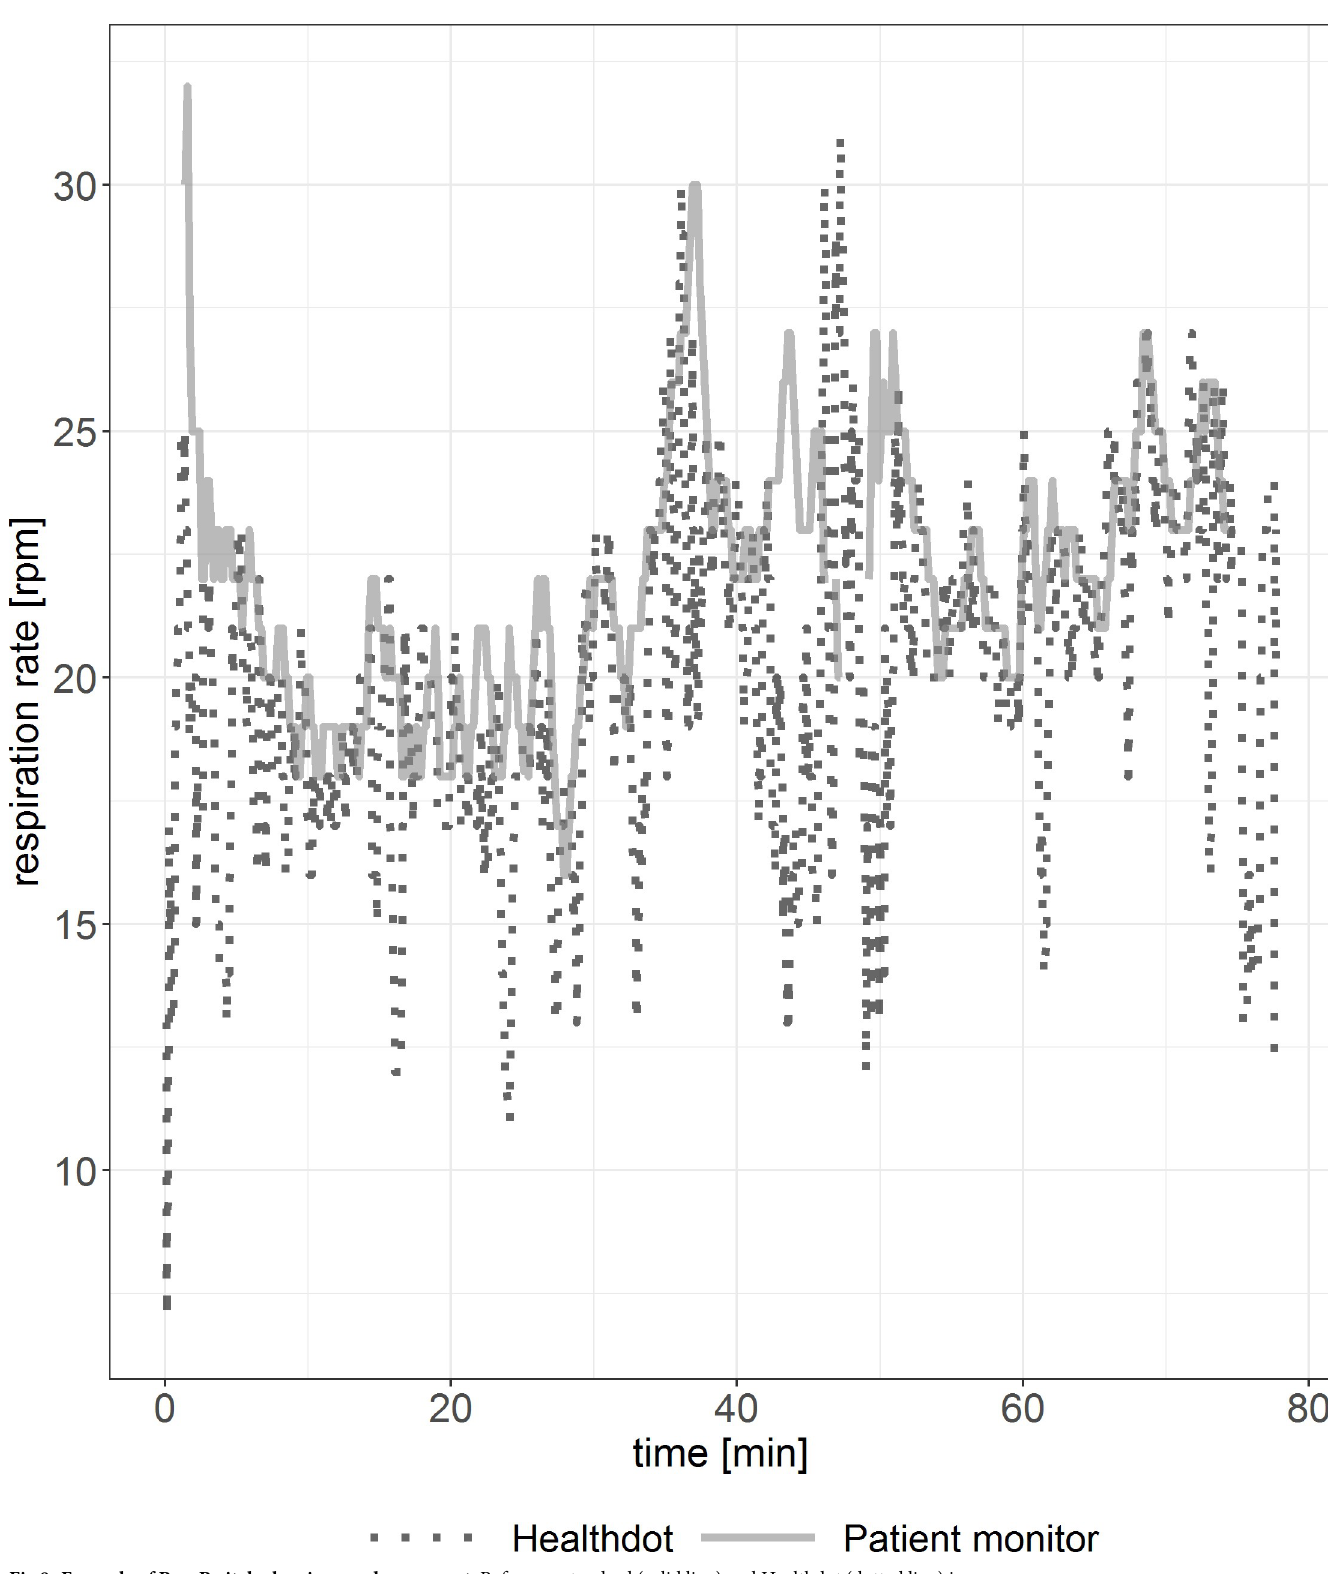
Fig 8. Example of RespR vitals showing good agreement. Reference standard (solid line) and Healthdot (dotted line) in rpm.